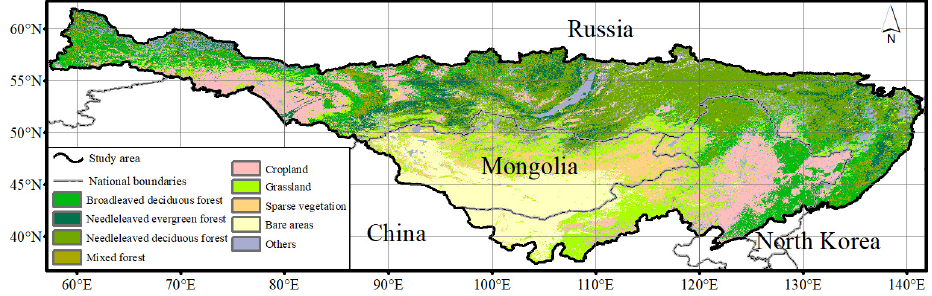
Figure 1. The spatial distribution of the main land cover types in the China–Mongolia–Russia International Economic International Economic Corridor.